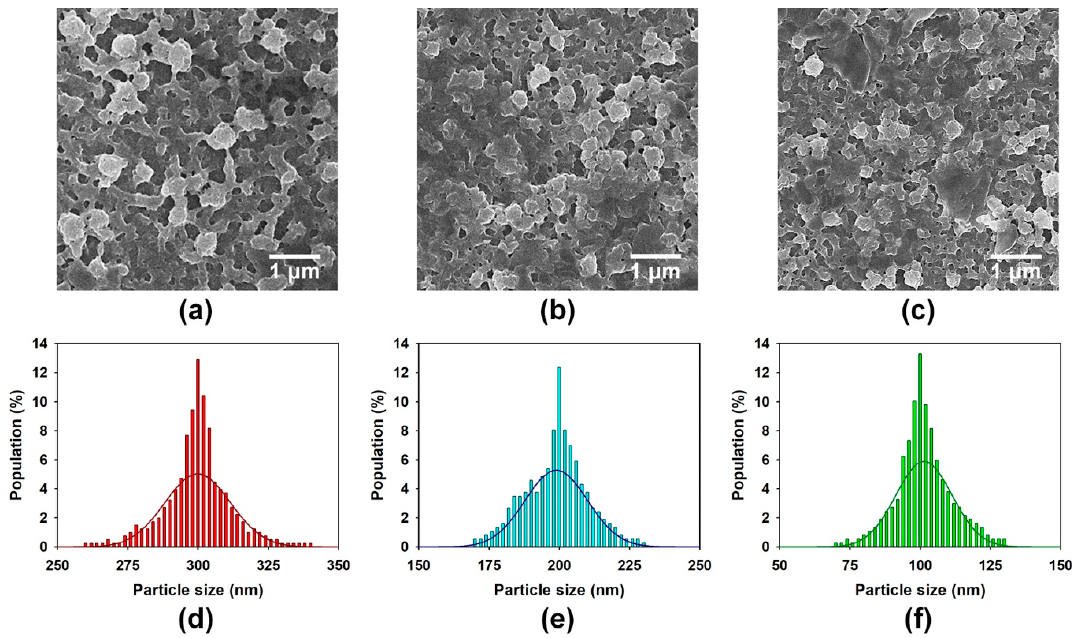
Figure 2. Field Emission Scanning Electron Microscope (FE-SEM) images of Polypyrrole:Poly(4- styrenesulfonate) (PPy:PSS) with different average molecular weights of PSS: ( a ) PPy:PSS with a PSS molecular weight of 1.0 × 10 6 g/mol (PPy100), ( b ) PPy:PSS with a PSS molecular weight of 2.0 × 10 5 g/mol (PPy20), and ( c ) PPy:PSS with a PSS molecular weight of 7.0 × 10 4 g/mol (PPy7). Histograms for the particle size distribution of ( d ) PPy100 ( e ) PPy20, and ( f ) PPy7. The number of PPy:PSS particles analyzed were 200 each.